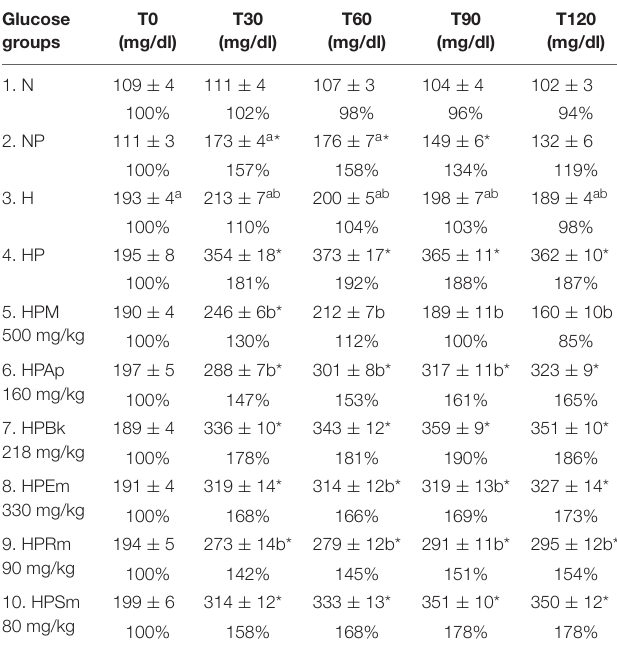
TABLE 1 | Plasma glucose values measured at the pyruvate tolerance test on STZ-NA induced hyperglycemic rats.